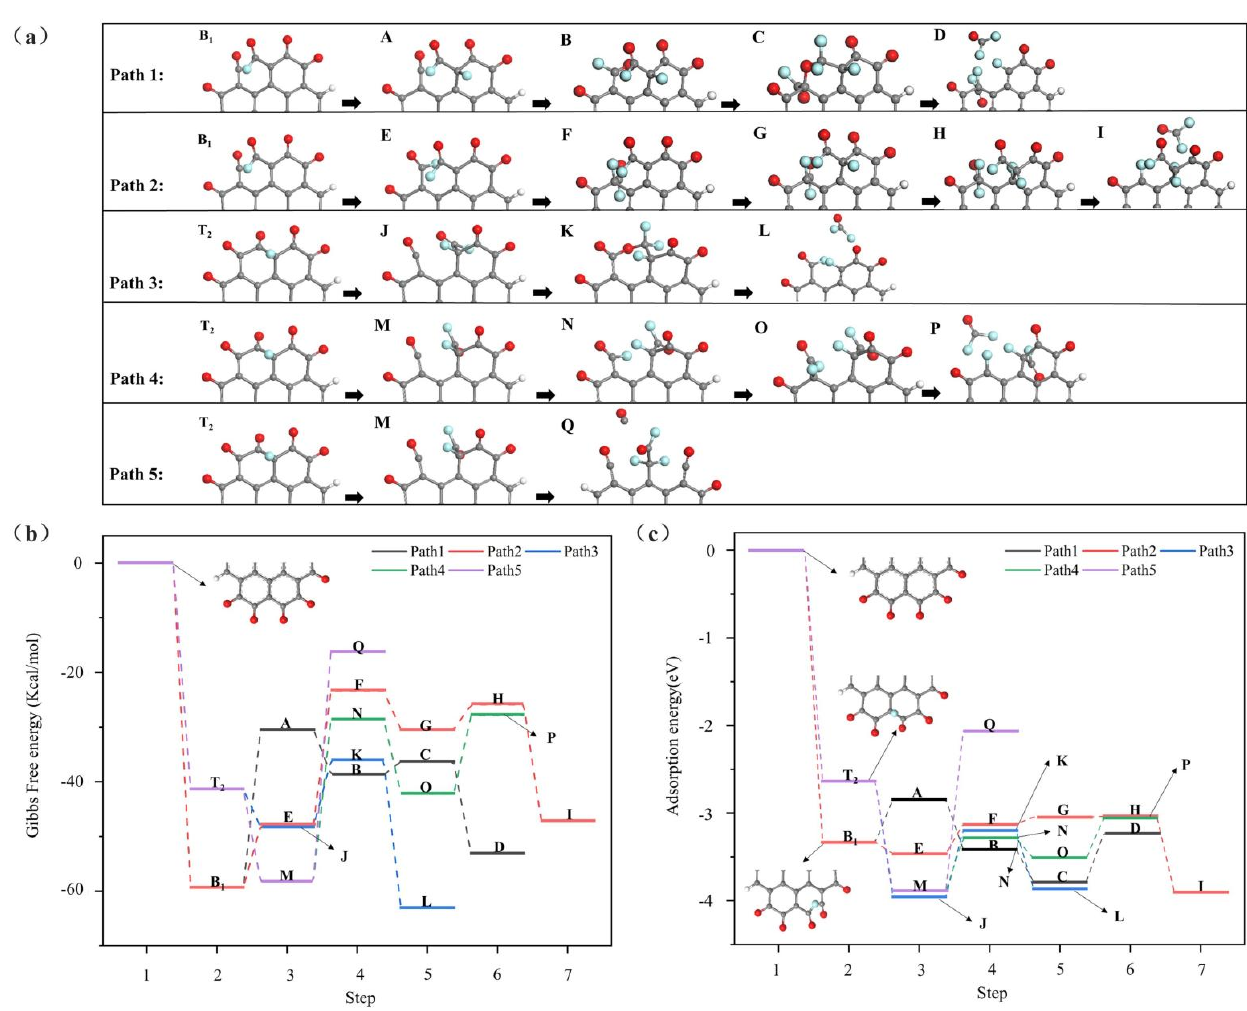
Figure 10. ( a ) Five possible paths for F atom adsorption on anode surface; ( b ) Gibbs free energy of five possible paths; ( c ) adsorption energy of five possible paths. The letters in the steps of ( b ) and ( c ) correspond to the letters in ( a ), representing different adsorption structures.